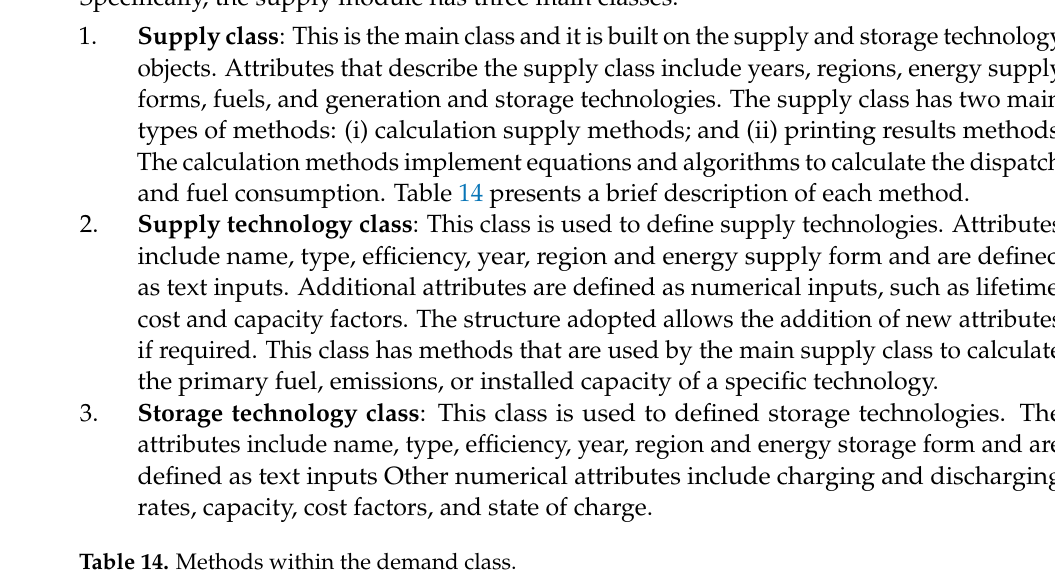
Table 14. Methods within the demand